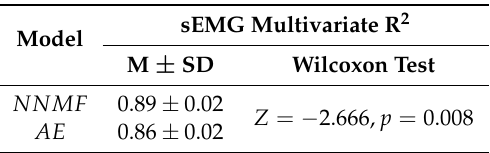
Table 3. Means and standard deviations of the sEMG Multivariate R 2 index values among all subjects. Results of the Wilcoxon Test about the comparison between the non-negative matrix factorization (NNMF) and